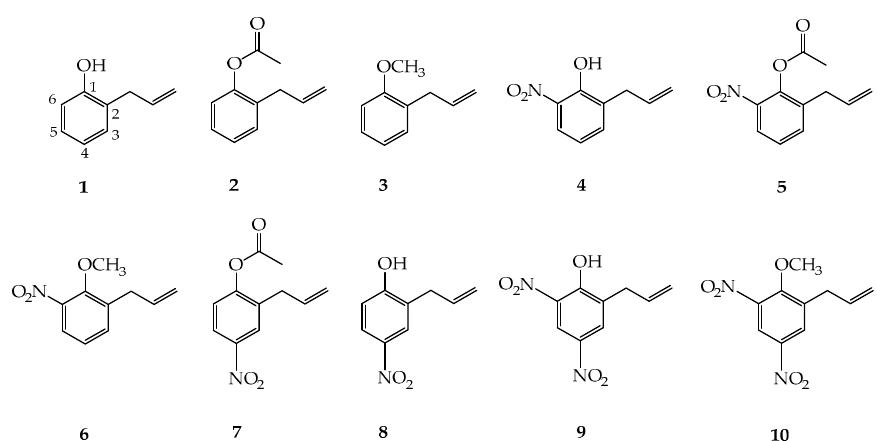
Figure 1. Chemical structures of 2-AP ( 1 ) and new synthesized derivatives ( 2 – 10